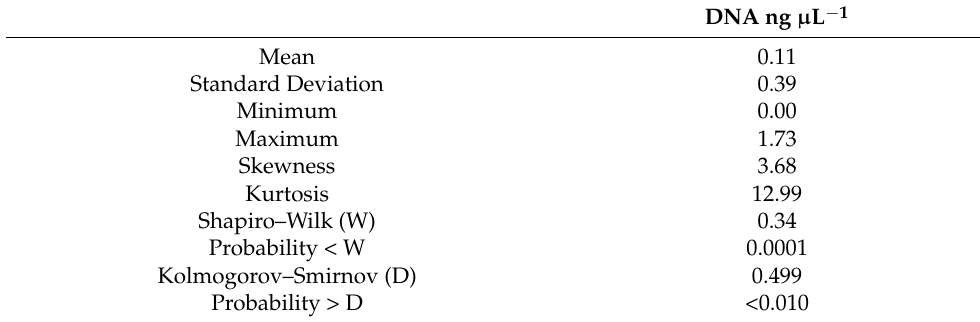
Table 1. Basic statistics of the DNA content and normality test results (Shapiro–Wilk and Kolmogorov– Smirnov).